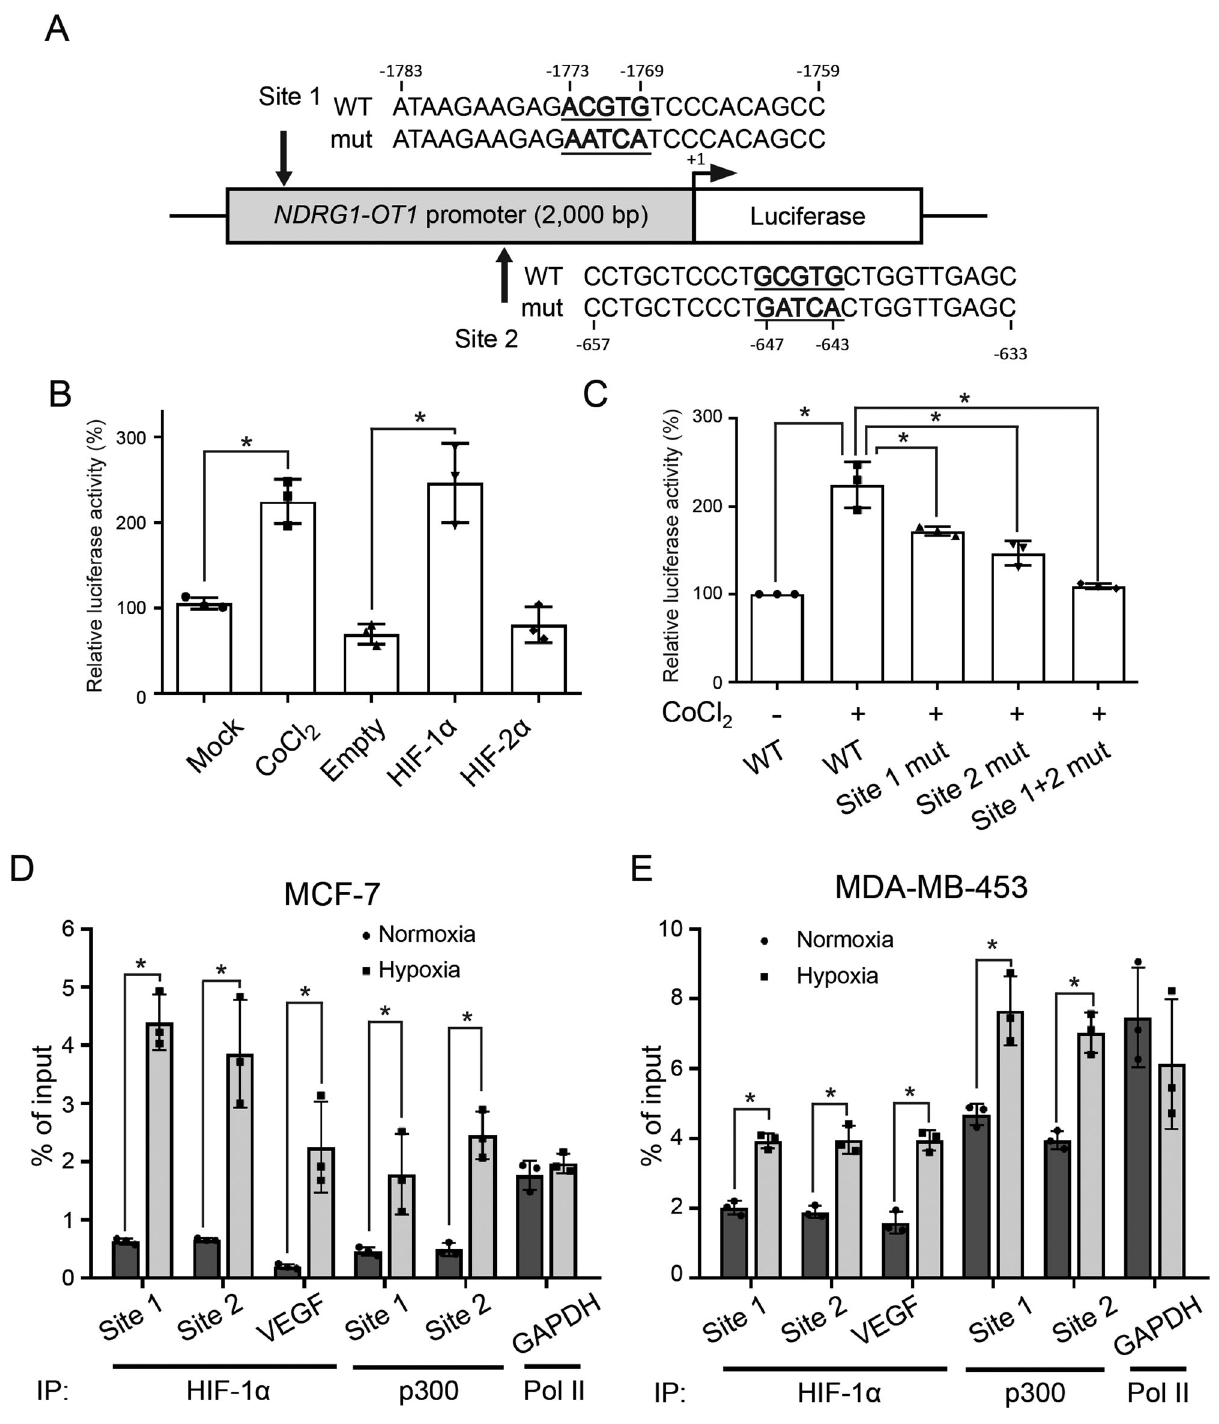
Fig. 3 HIF-1 α and p300 physically binds to the promoter of NDRG1-OT1 . A Schematic representation of fi re fl y luciferase constructs containing the NDRG1-OT1 promoter ( − 2000 to − 1 bp), showing both the wild-type sequence (WT) and the mutation of the HIF-1 α binding sites (mut). There are two putative HREs ([A/G]CGTG) within the promoter of NDRG1-OT1 . Site 1: − 1773 to − 1769 bp; site 2: − 647 to − 643 bp. B Luciferase reporter assays of NDRG1-OT1 promoter in cells treated with CoCl 2 , or overexpressing HIF-1 α or HIF-2 α . HEK293T cells were transfected with HIF-1 α or HIF-2 α expressing plasmids, fi re fl y luciferase plasmids, and Renilla reporter vectors. The CoCl 2 treatments were administered for 24 h. The relative fi re fl y luciferase activity was measured and normalized to Renilla luciferase activity. C Luciferase reporter assays of NDRG1-OT1 mutant promoters in cells treated with CoCl 2 . HEK293T cells were transfected with indicated fi re fl y plasmids and Renilla reporter vectors. The CoCl 2 treatments were administered for another 24 h after transfection of plasmids for 24 h. D , E ChIP of HIF-1 α , p300, and NDRG1-OT1 promoter in MCF-7 ( D ) and MDA-MB-453 ( E ) cells under hypoxia. Anti-HIF-1 α or anti-p300 antibody was used to precipitate chromatin, and DNA was examined by primers fl anking site 1 or site 2 of the NDRG1-OT1 promoter. VEGF promoter served as a positive control. Chromatin precipitated by anti-RNA polymerase II antibody was ampli fi ed by primers fl anking the GAPDH promoter and served as a negative control. The relative chromatin enrichment (%) was normalized to input. All data shown are the means ± SDs ( n = 3). IP immunoprecipitation. * P < 0.05.